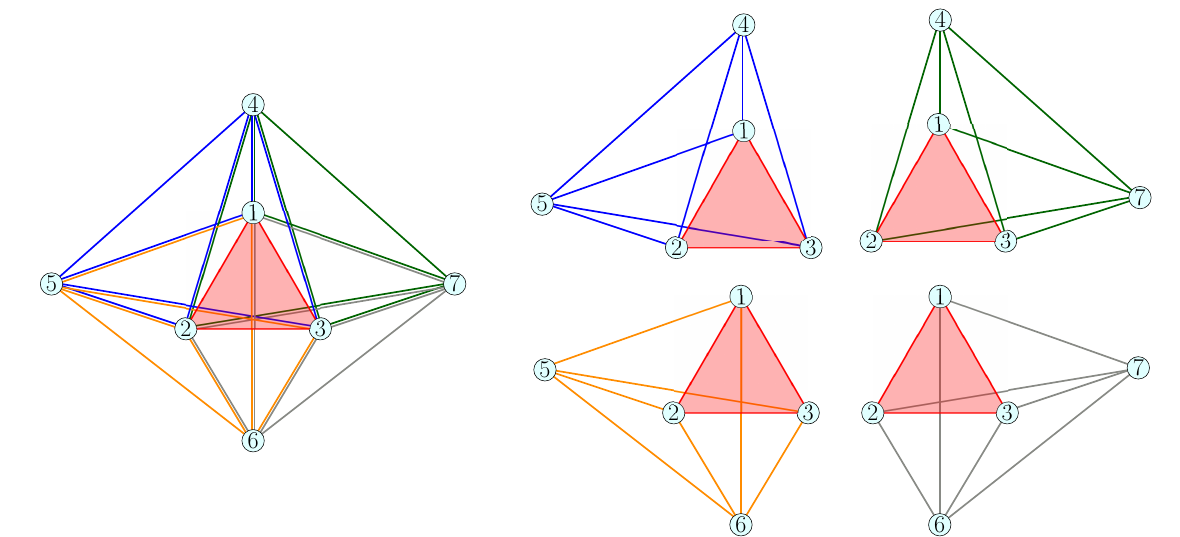
Figure 1. The ∆ 4 triangulation. The numbered circles correspond to points, while lines correspond to segments. Each color corresponds to a different 4-simplex. The bulk triangle 123 is highlighted in red. In the right panel, the 4-simplices are shown separately.